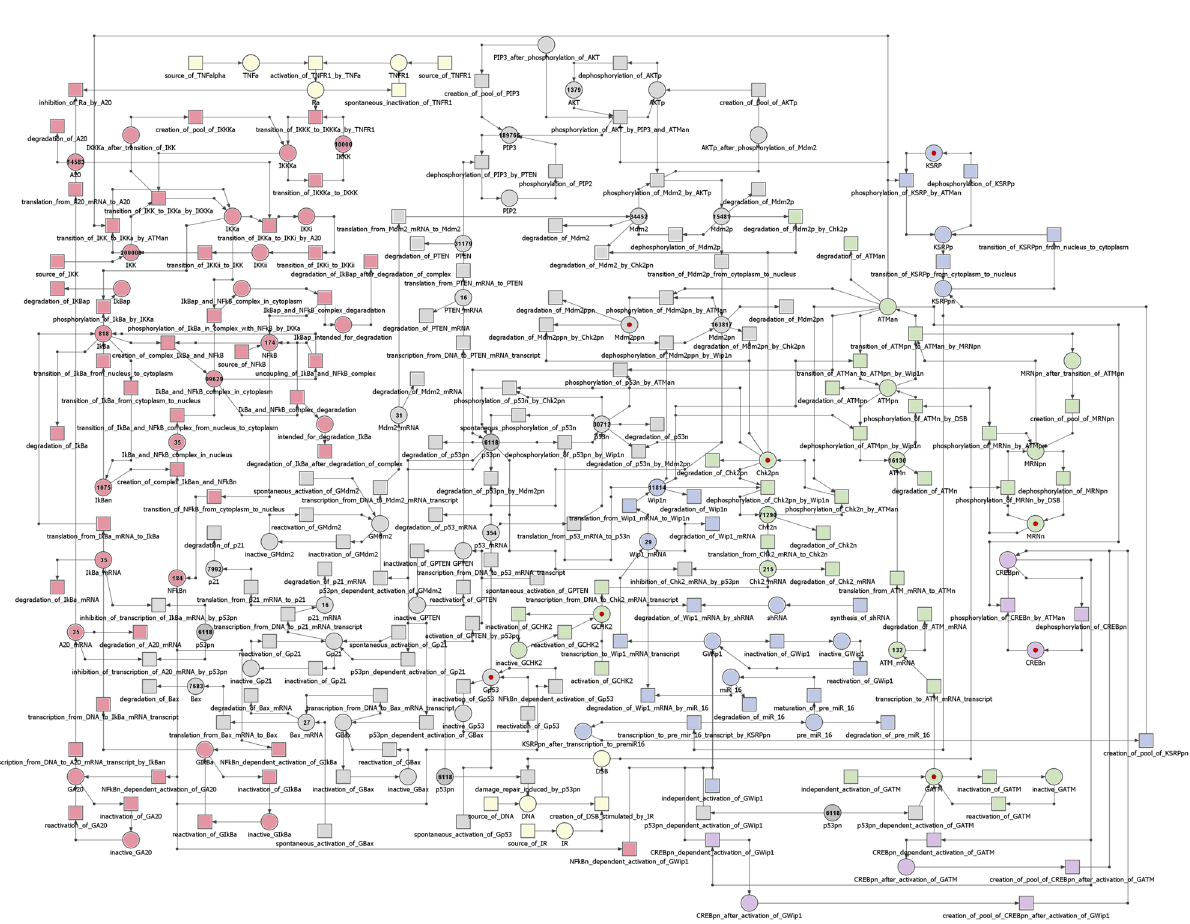
Figure 3. The proposed model of the ATM–p53–NF- κ B pathways with two excitations (TNF and IR) (541 t-inv). The presented Petri net is divided into several modules: ATM (green), p53 (gray), NF- κ B (red), WIP1 (blue), CREB (purple) and inputs of the system (yellow). The places which are marked with the same color and name correspond to the same particle (logic place), they are used only for transparency in the